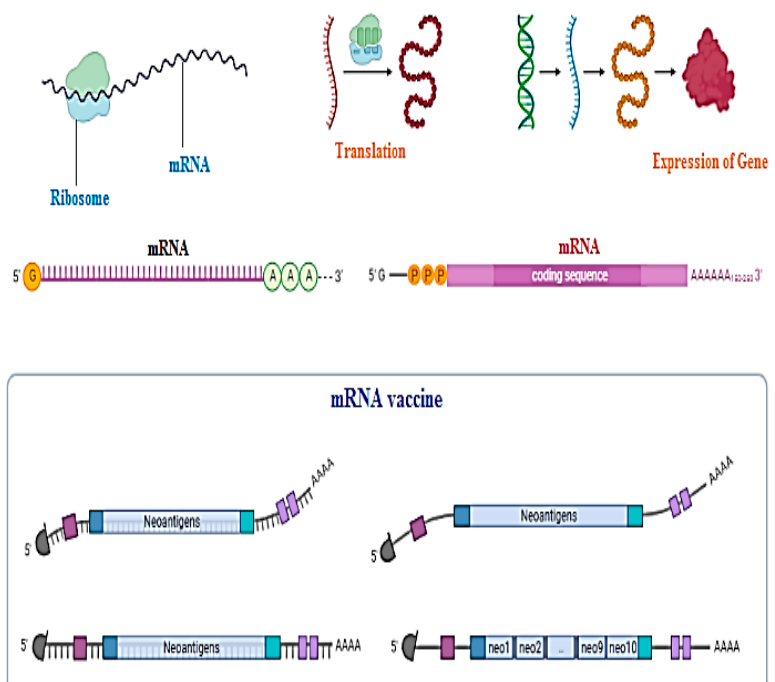
Figure 9. Difference between normal blood–brain barrier showing normal occluding and claudin protein junctions, and brain tumor blood–brain barrier disturbing occluding and claudin by invad- ing the normal cell membrane [83,98,104].